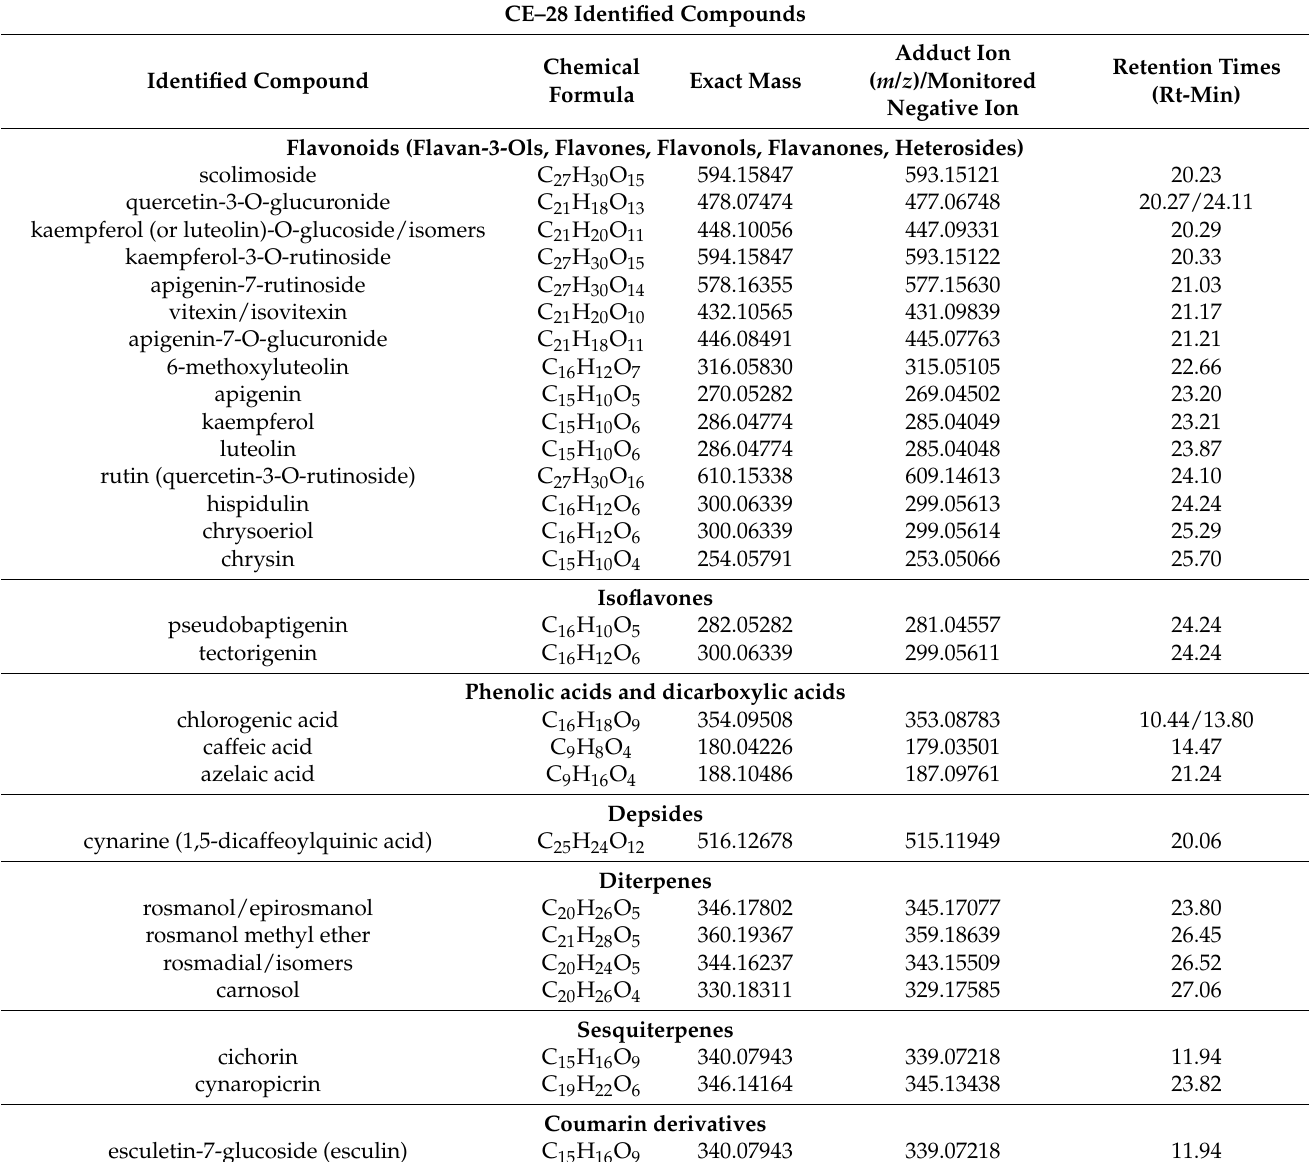
Table 2. Chemical compounds identified in CE by